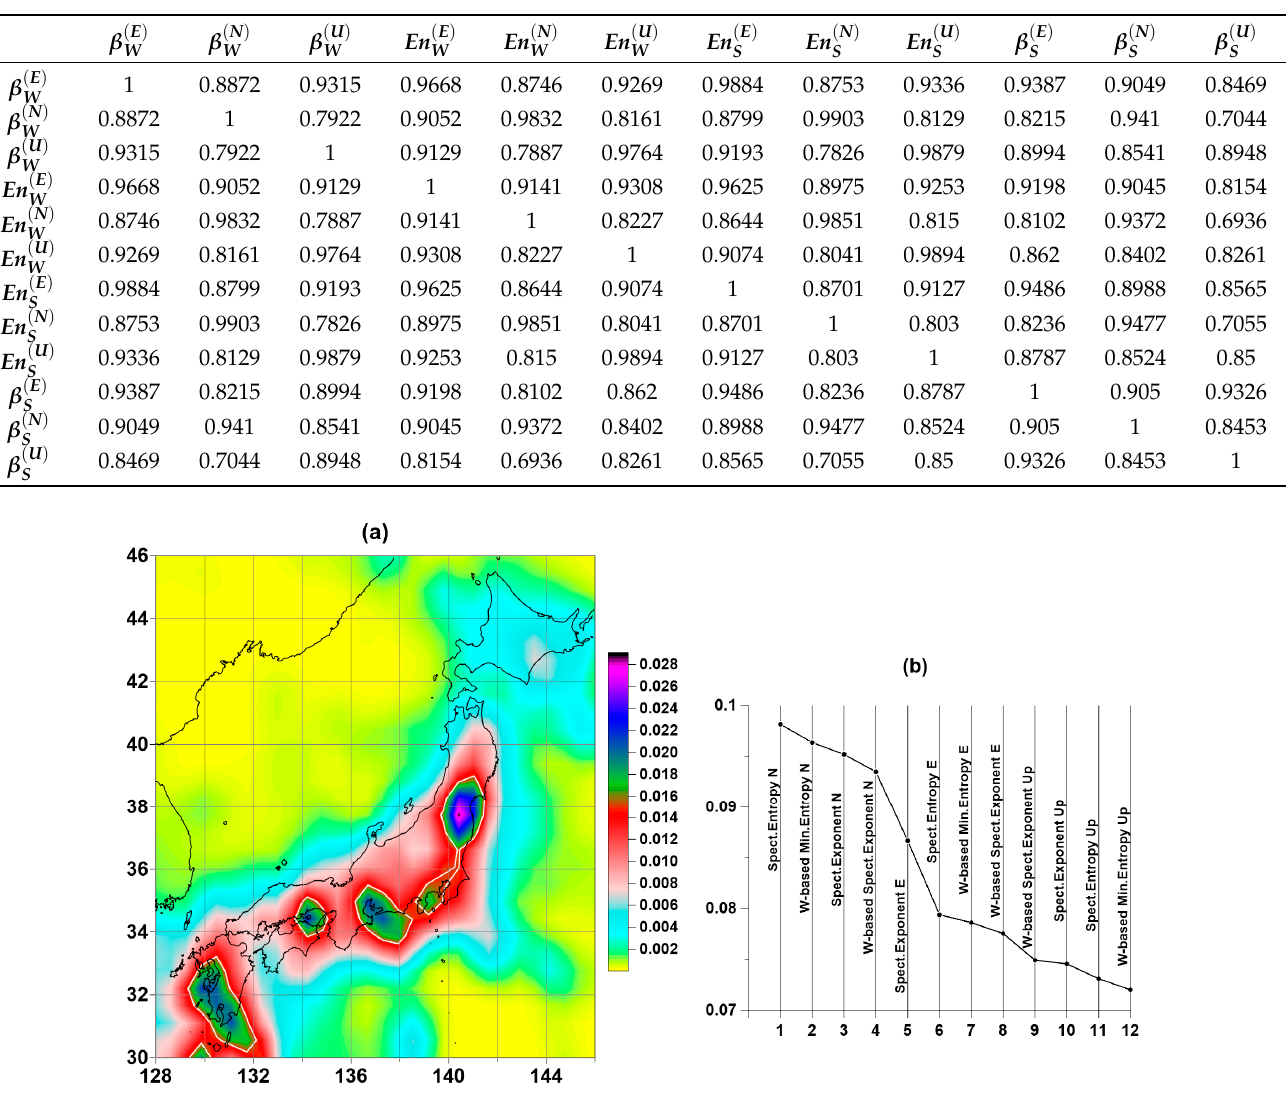
Table 1. Matrix of pairwise correlation coefficients between 12 average probability density maps of extreme values of ground tremor statistics.